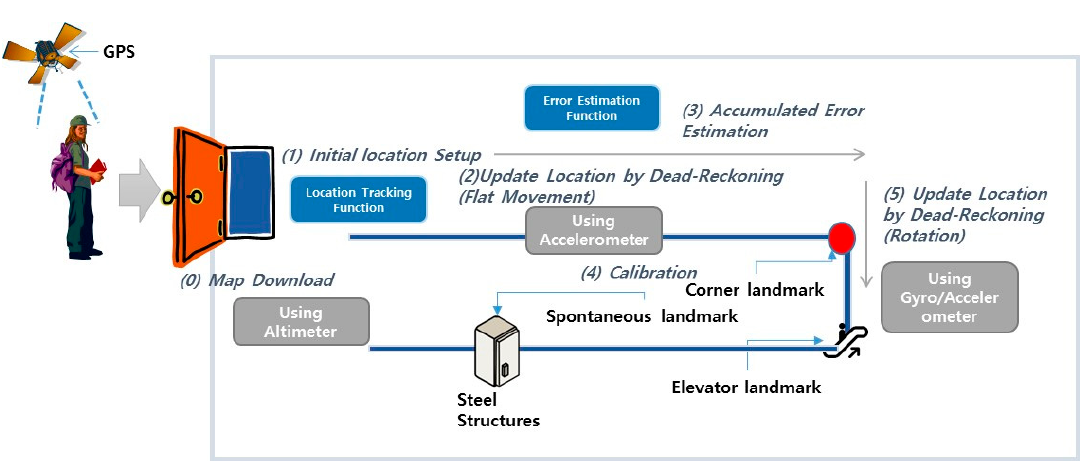
Figure 4. Process of landmark identification and location estimation.